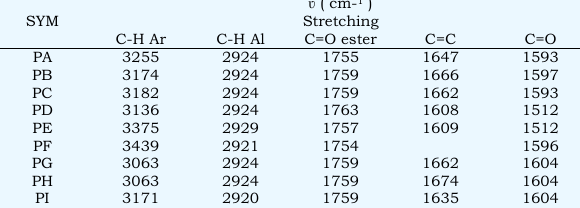
Table 2 IR data of prepared polymers (PA-PI) phph SYM